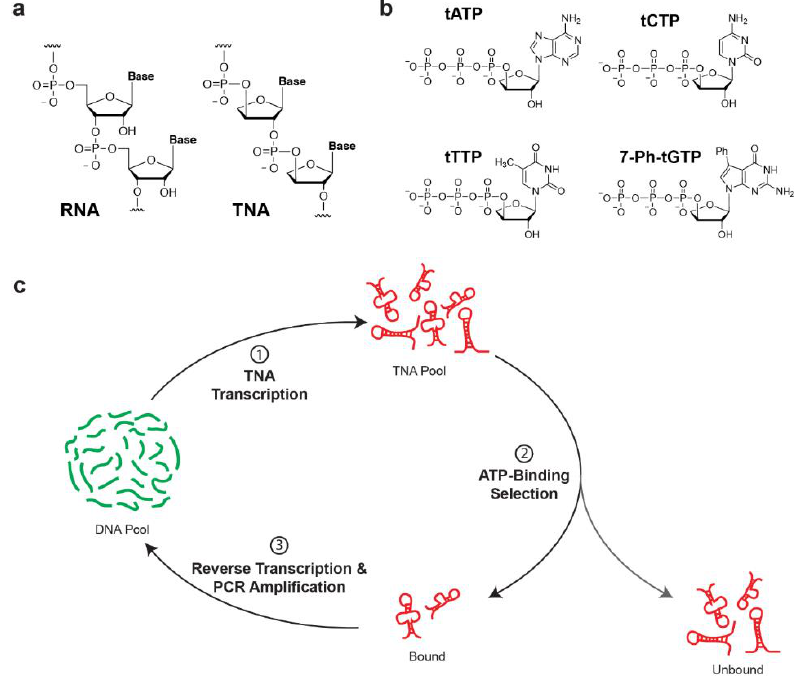
Figure 1. Selection of threose nucleic acid (TNA) aptamers. ( a ) Chemical structures of RNA and TNA. ( b ) tNTP substrates used to enzymatically synthesize TNA molecules for in vitro selection. ( c ) Cartoon image of the in vitro selection strategy used to isolate ATP-binding TNA aptamers.